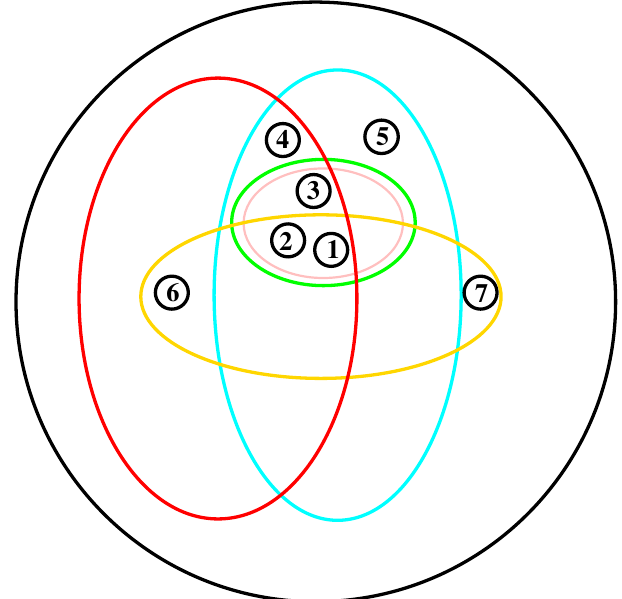
FIG. 1. (Color) The logical connections between the various Inside the blue ellipse: tori, which at every (cid:13) proper UPF (note that for those tori every spin trajectory is quasiperiodic). Inside the green ellipse: tori which are well-tuned (see Sec. V). Inside the yellow ellipse: tori which are off orbital resonance. Inside the pink ellipse: tori with a uniform IFF. The numbered circles label specific examples, as follows.